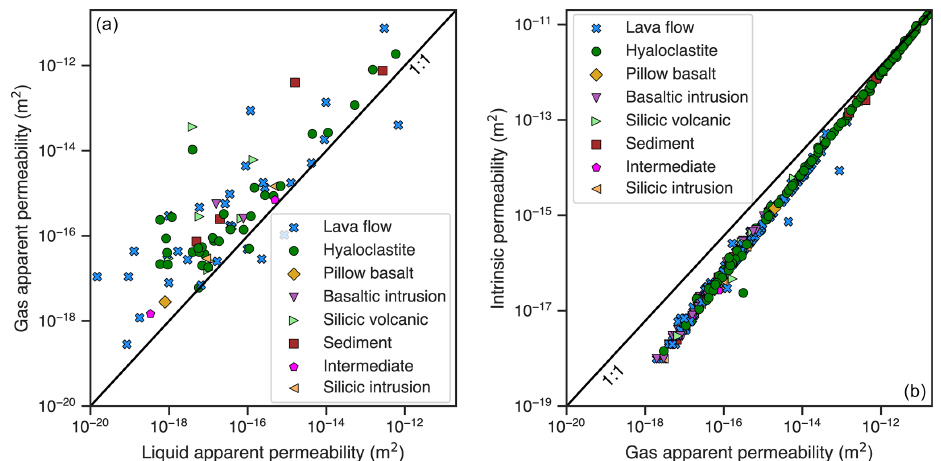
Figure 6. Permeability data: (a) a comparison of the liquid apparent permeability and the gas apparent permeability and (b) a comparison of the gas apparent permeability and the intrinsic permeability; the difference between these two quantities mainly reflects the Klinkenberg correction (see text).